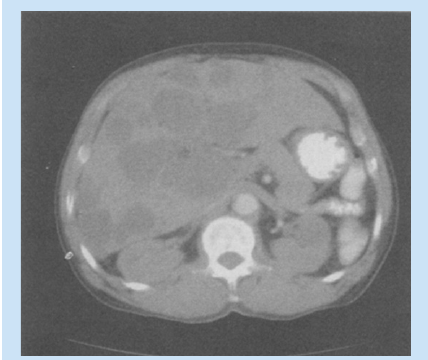
Fig. 3c. MRI confirming multiple hepatic cysts with high signal on T2-weighted